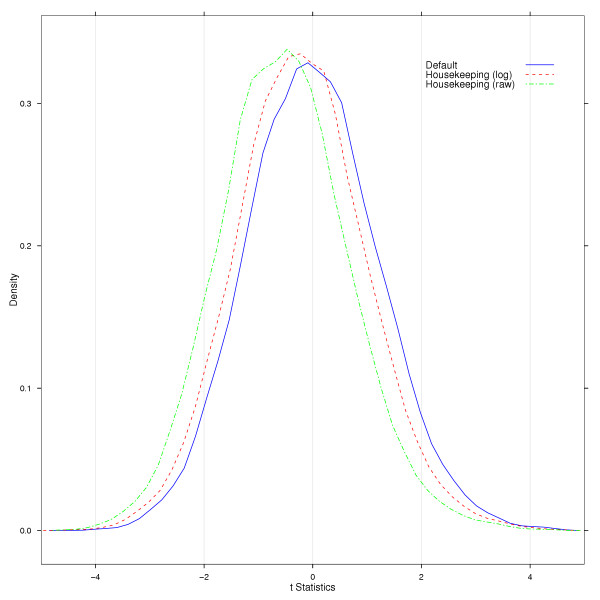
Distributions of t-statistics calculated from differently normalized MAS5 expression values in the Breast Cancer data. The normalization procedures applied were the same as in Figure 3: global mean as default and housekeeping normalization before and after taking logarithms (raw and log respectively in the legend.) The t-statistics compare expression values between users and non-users of hormone replacement therapy (HRT) in the sample. The density curves show the smoothed histograms of the test statistics for all 22283 probe sets on the chip. The default curve is centered at zero, indicating balanced up- and down-regulation in reaction to HRT, whereas the curves for the housekeeping-normalized data are shifted to the left, indicating a massive down-regulation of thousands of genes in HRT users, which is biologically much less plausible. This effect is more pronounced for the raw than for the logged normalization, same as with the residual correlations shown in Figure 3.